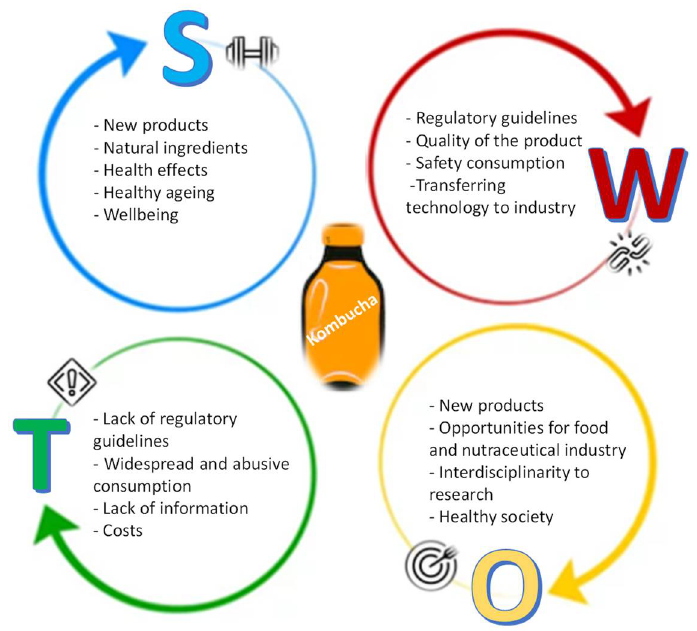
Figure 3. S.W.O.T. analysis for Kombucha